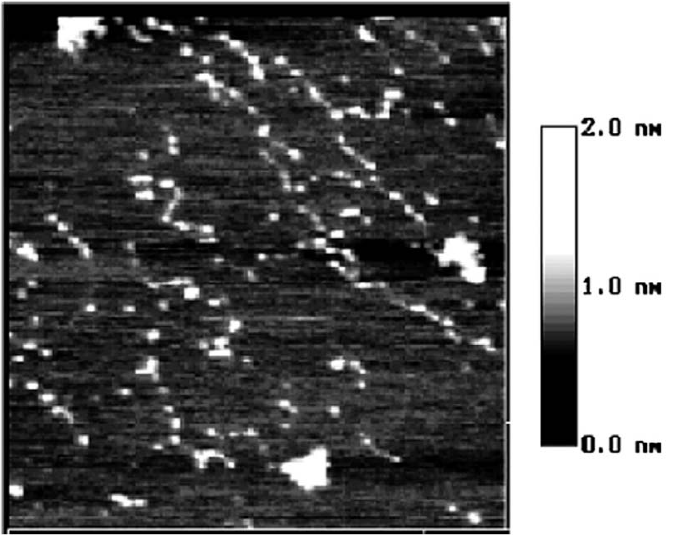
Figure 5. The AFM image of starch nanochains when heated in 100 °C water bath for 20 min, size 1.0 × 1.0 µm.